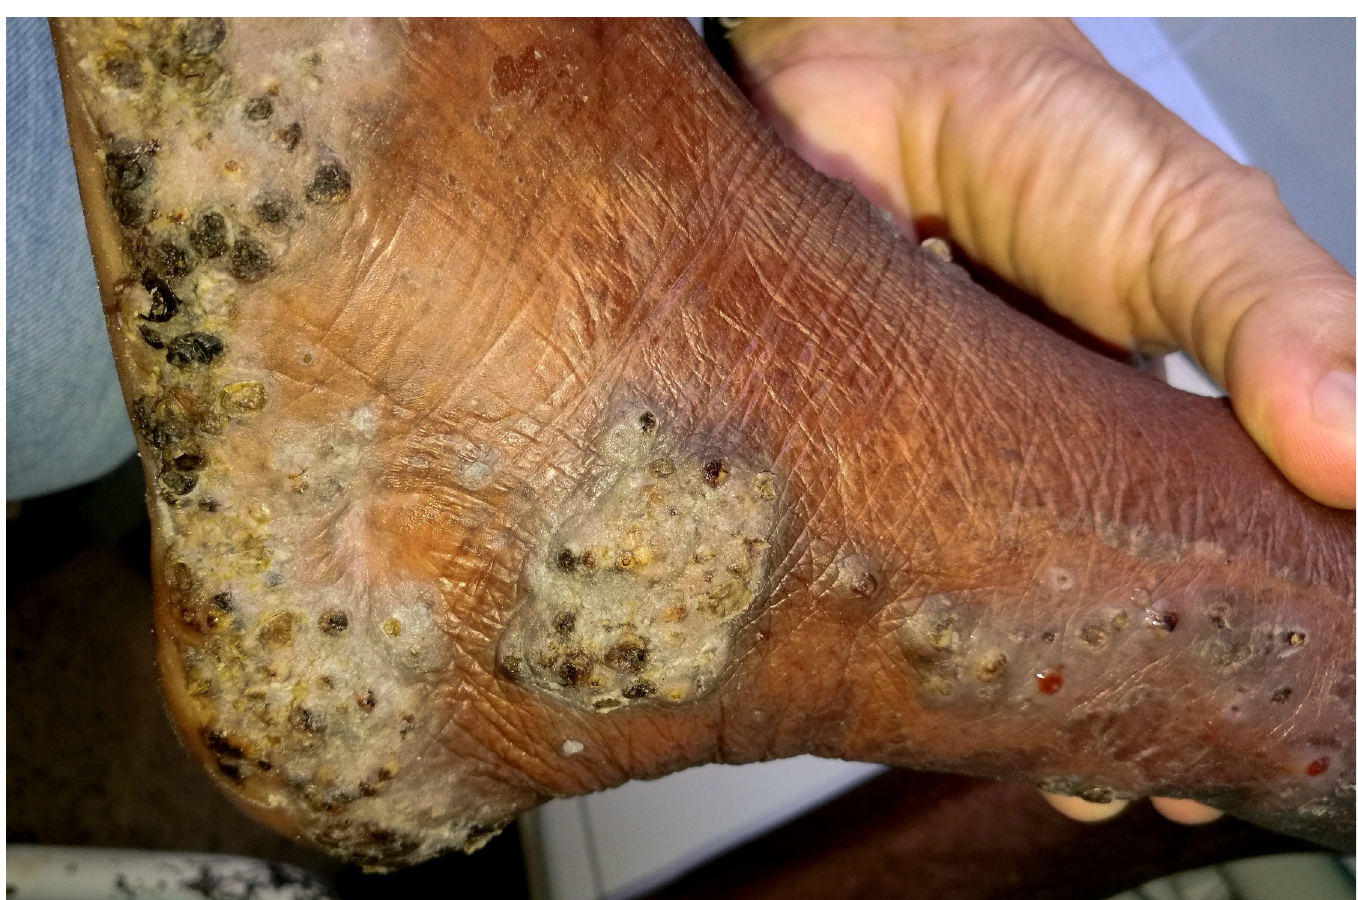
Fig 3. Clusters of embedded sand fleas at the ankle and the lateral side of the lower